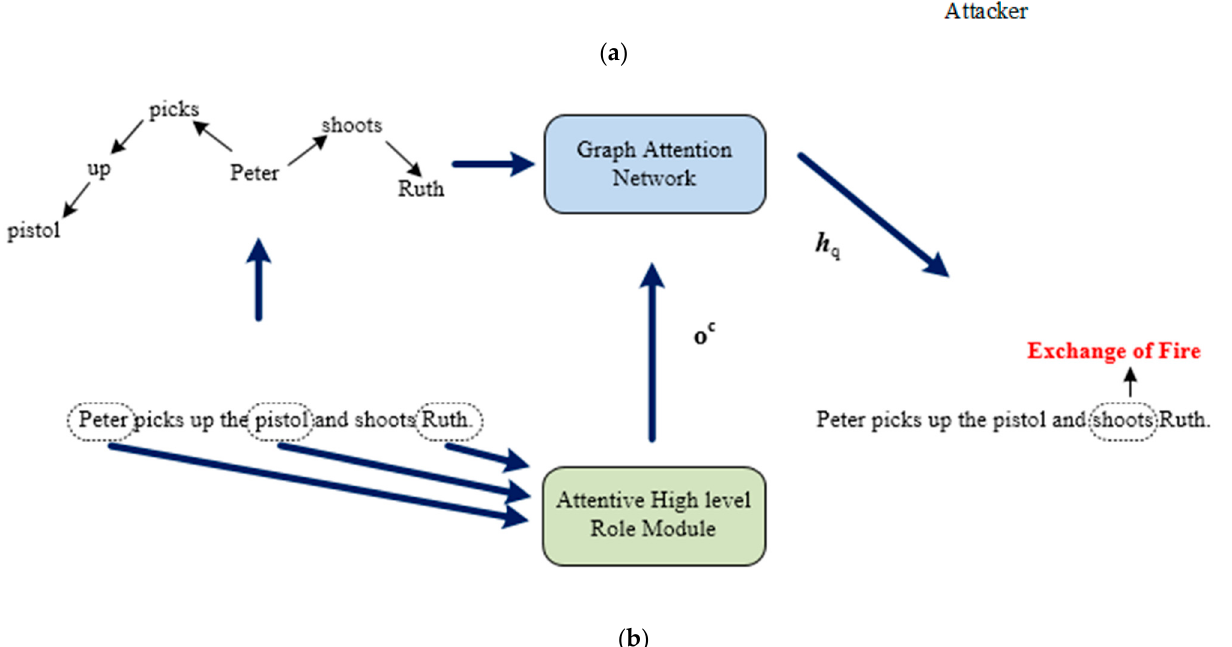
Figure 3. ( a ) The overall framework of the whole event extraction model; ( b ) the details of trigger extraction.